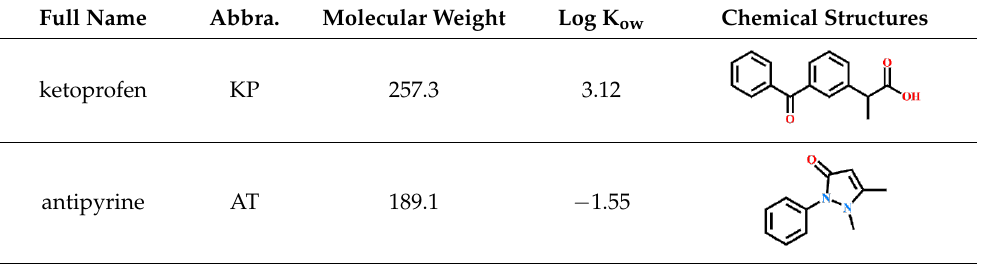
Table 1. Pharmaceuticals used in this study.